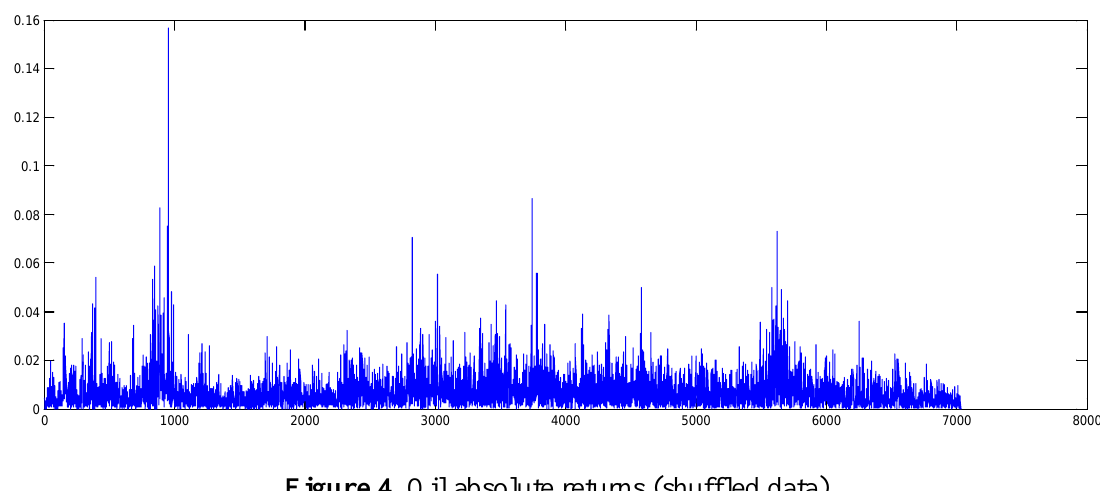
Figure 4. Oil absolute returns (shuffled